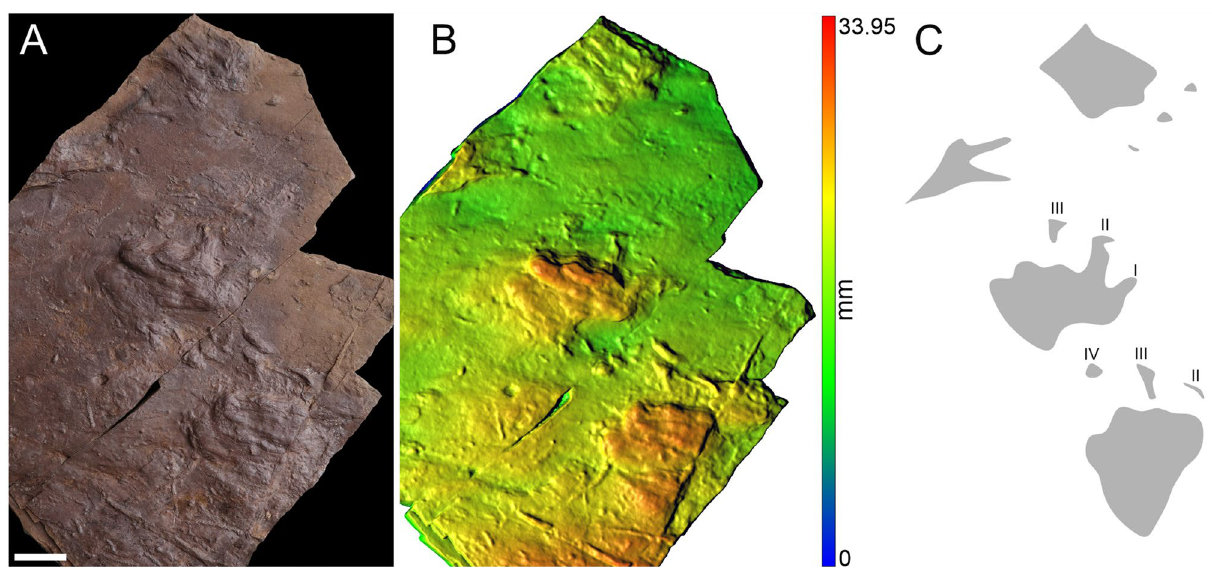
Figure 4. The manus-pes couple and two isolated incomplete tracks of MZM Ge 33072 (convex hyporelief) ( A ), image ‐ based modeling ( B ), and the outline drawing ( C ). Scale bar 4